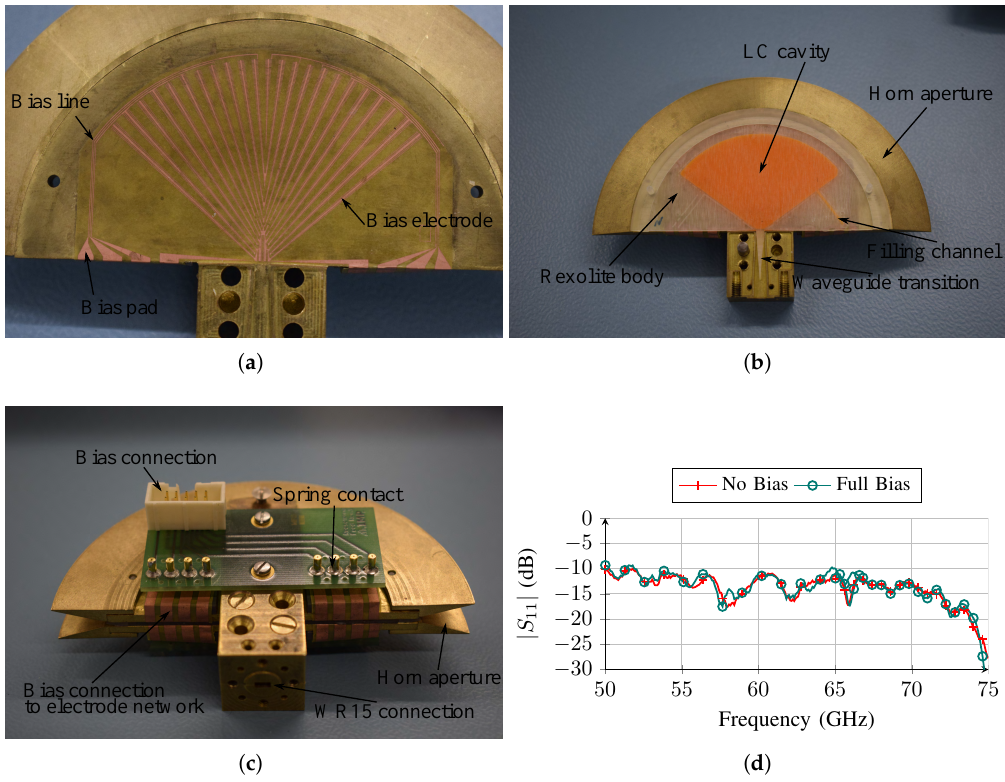
Figure 43. ( a ) Top electrode network, ( b ) inserted Rexolite body with LC, ( c ) assembled demonstrator, and ( d ) measured input reflection for different bias states.